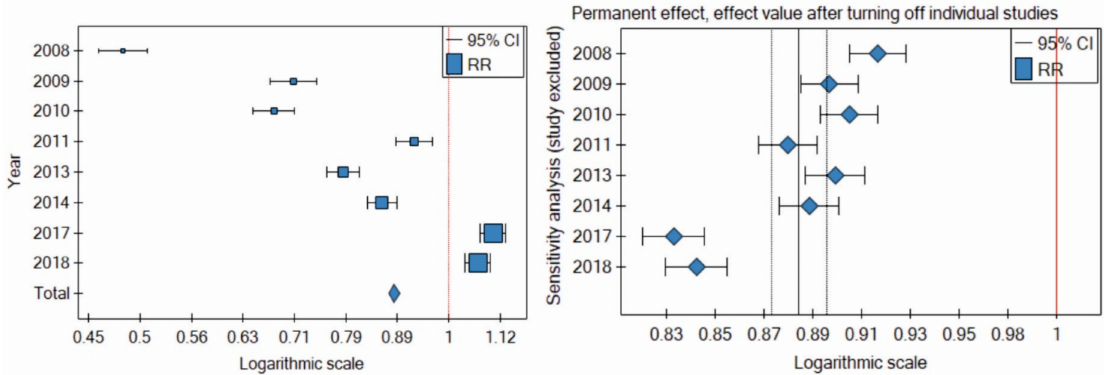
Figure 8. The relative risk of an accident at work among workers aged 60–64 years employed in Poland (own elaboration).